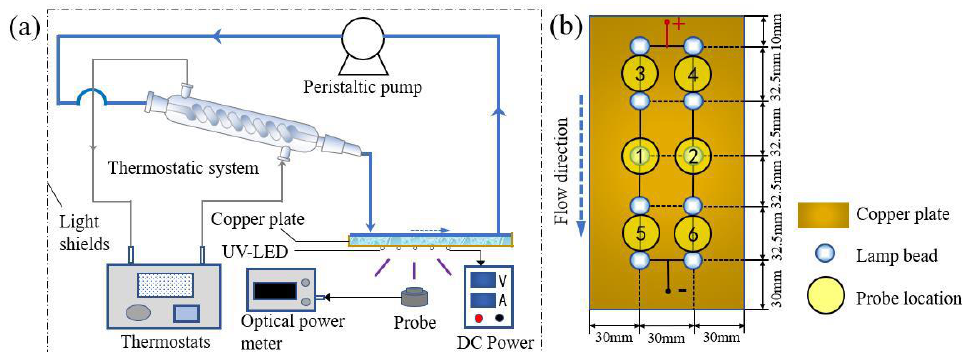
Figure 14. ( a ) Schematic diagram of the optical power measurement system. ( b ) Optical power meter probe location schematic. The six probe locations are numbered 1 to 6. The wastewater flow direction is from location 3, 4 to location 5, 6.